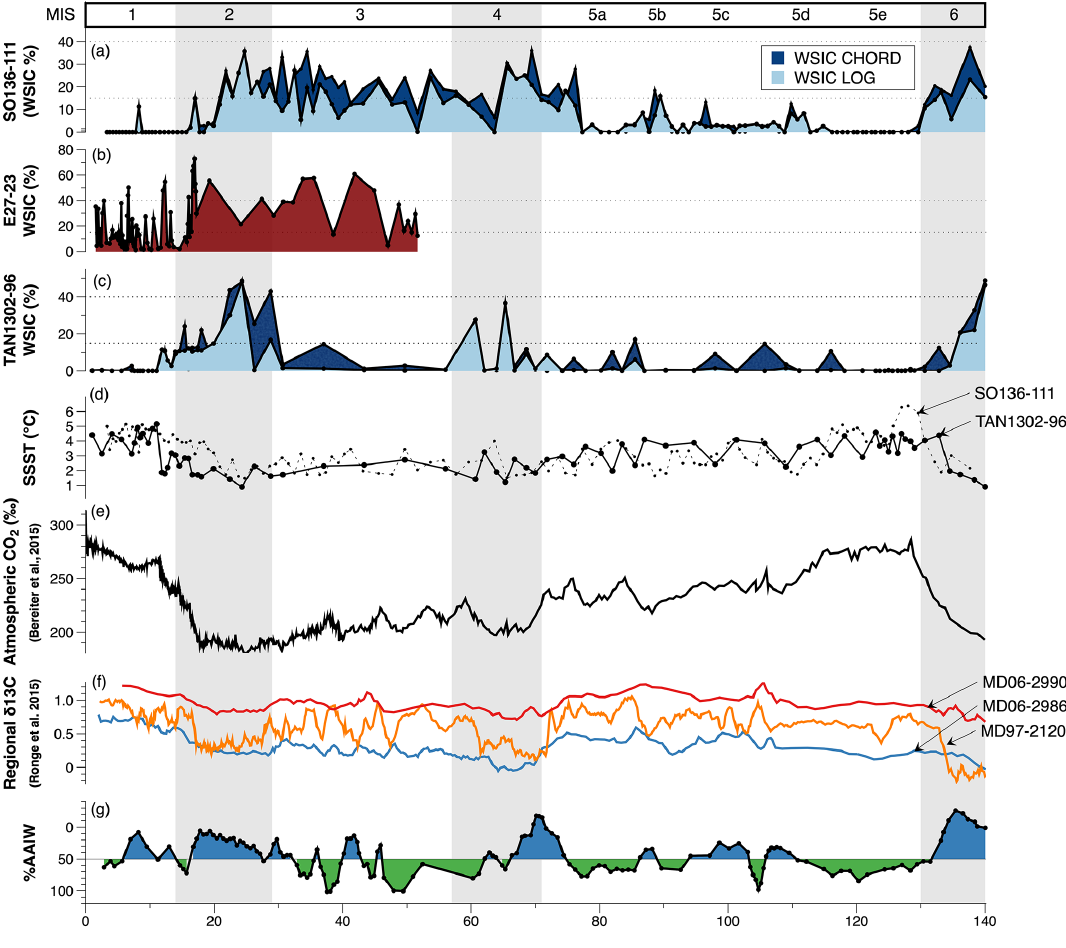
Figure 5. (a) WSIC estimates using MAT from SO136-111 (recalculated in this study; see Appendix D); (b) WSIC estimates using GAM from E27-23 (Ferry et al., 2015); (c) WSIC estimates using MAT from TAN1302-96 (this study); (d) SSST estimates using MAT from TAN1302-96 (solid black line) and recalculated SSST for SO136-111 (black dotted line); (e) Antarctic atmospheric CO 2 concentrations over 140ka (Bereiter et al., 2015); (f) δ 13 C data from nearby cores MD06-2990/SO136-003, MD97-2120, and MD06-2986 (Ronge et al., 2015); (g) %Antarctic Intermediate Water (%AAIW) as calculated in Ronge et al. (2015), which tracks when core MD97-2120 was bathed primarily by AAIW (green) or Upper Circumpolar Deep Water (UCDW)